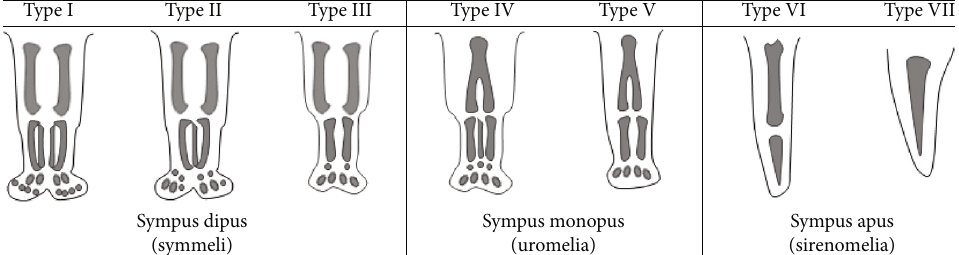
Figure 7: Classi fi cation of sirenomelia by Stocker and Heifetz [2]. Type I: all bones of thigh and lower leg present; type II: fused fi bula; type III: fi bula absent; type IV: partially fused femur, fused fi bula; type V: partially fused femur, fi bula absent; type VI: fused femur, fused tibia; type VII: fused femur, tibia